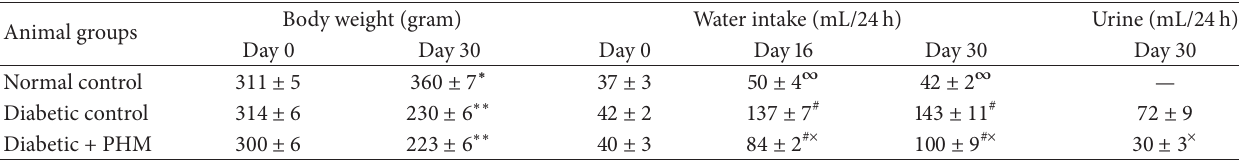
Table 1: Effects of the polyherbal mixture (PHM) on body weight and water intake. The animals in group of diabetic + PHM received PHM for 4 weeks.